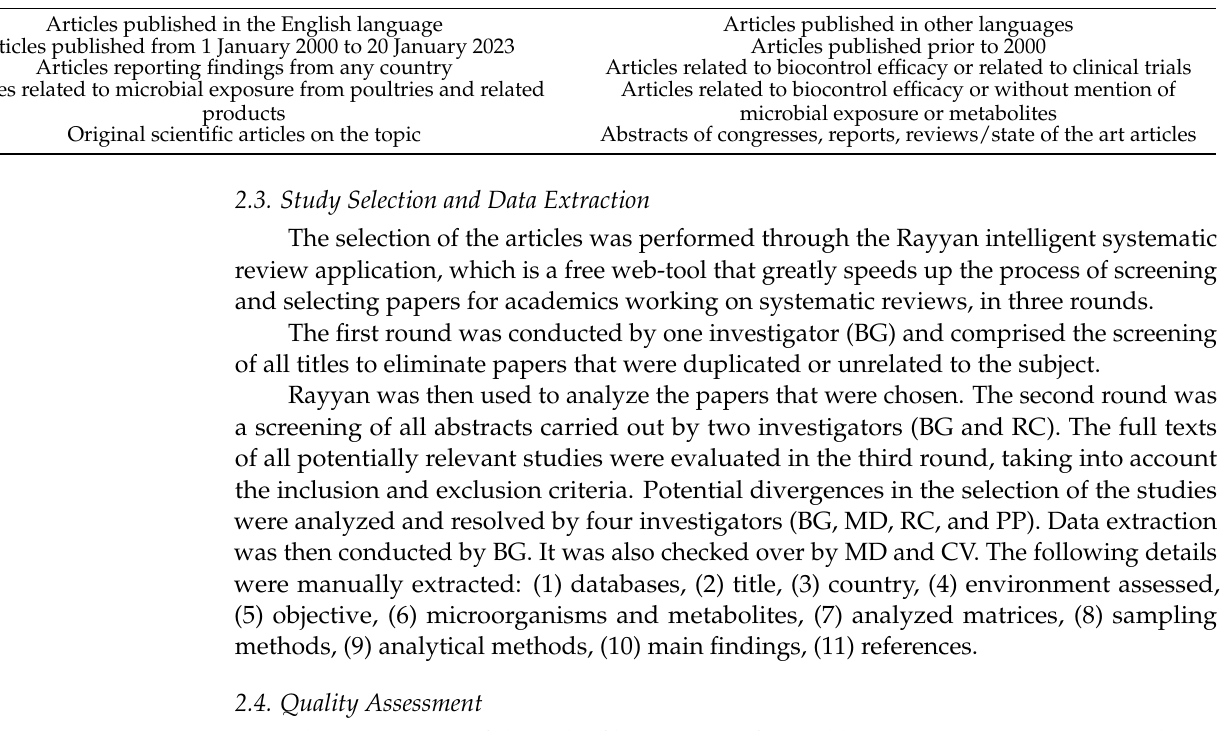
Table 1. Inclusion and exclusion criteria for the articles selected. Inclusion